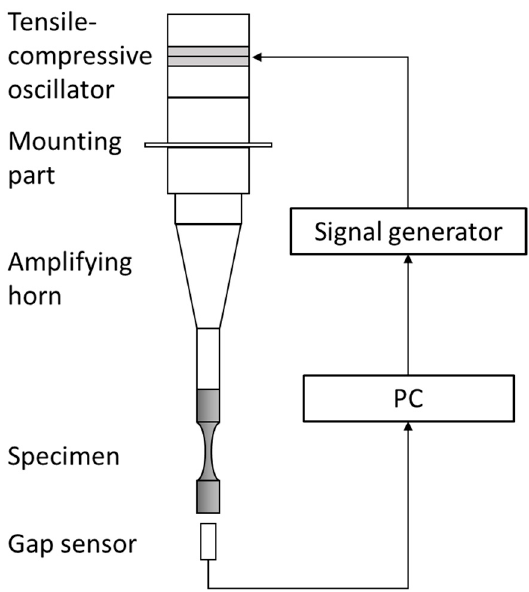
Figure 1. Configuration of an ultrasonic fatigue testing machine.